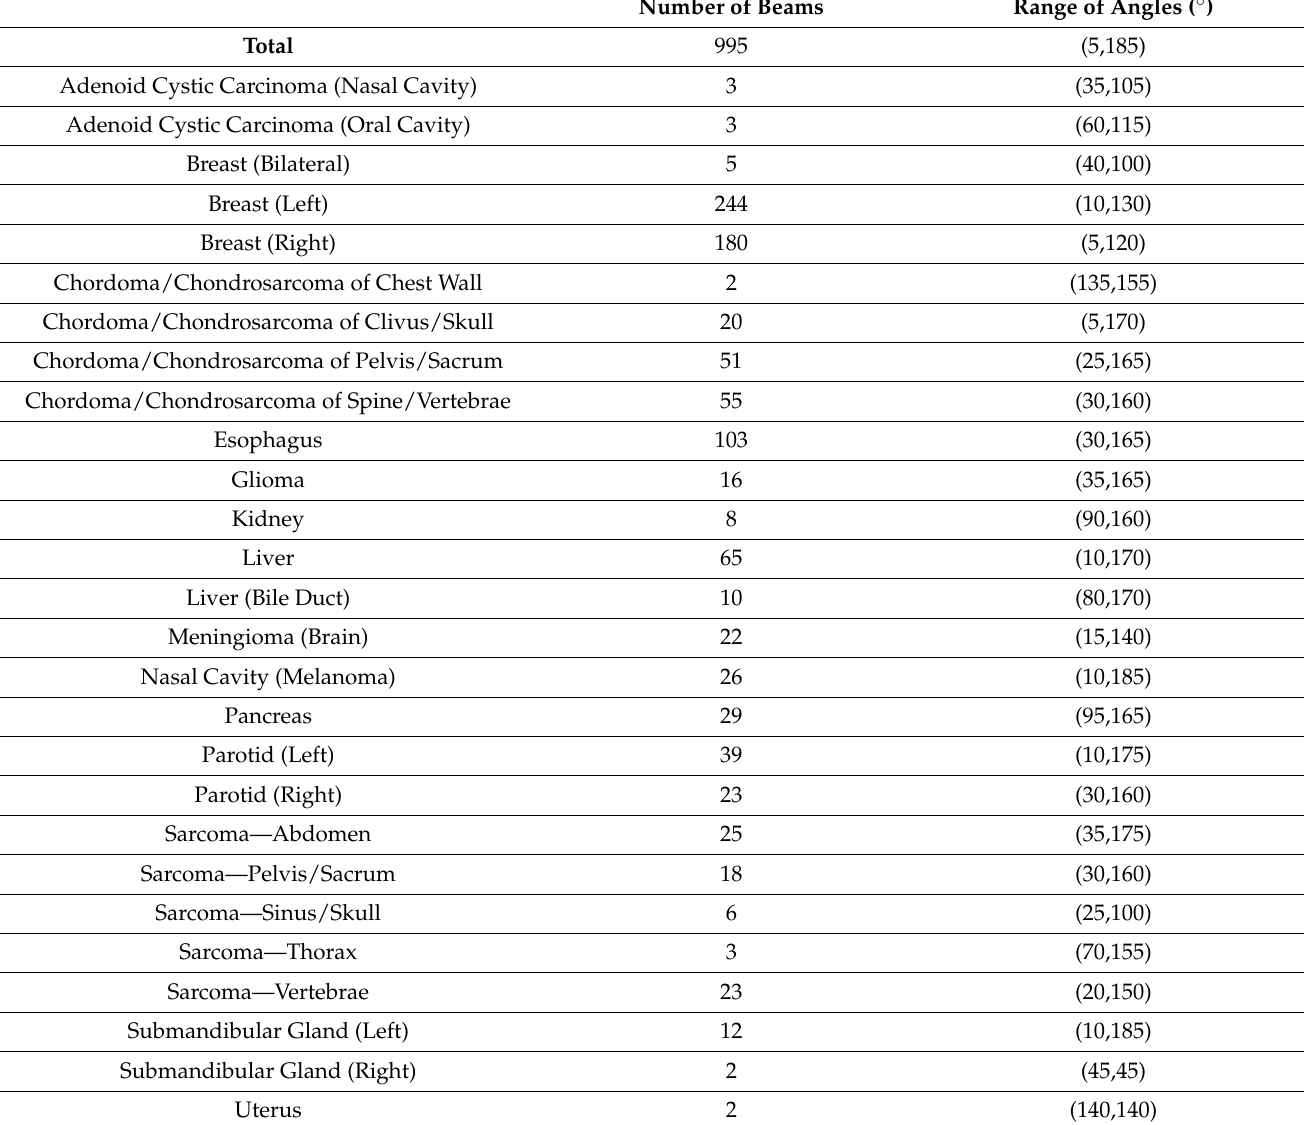
Table 2. Patients treated with proton therapy by treatment site (excluding 0 ◦ and 180 ◦ ).